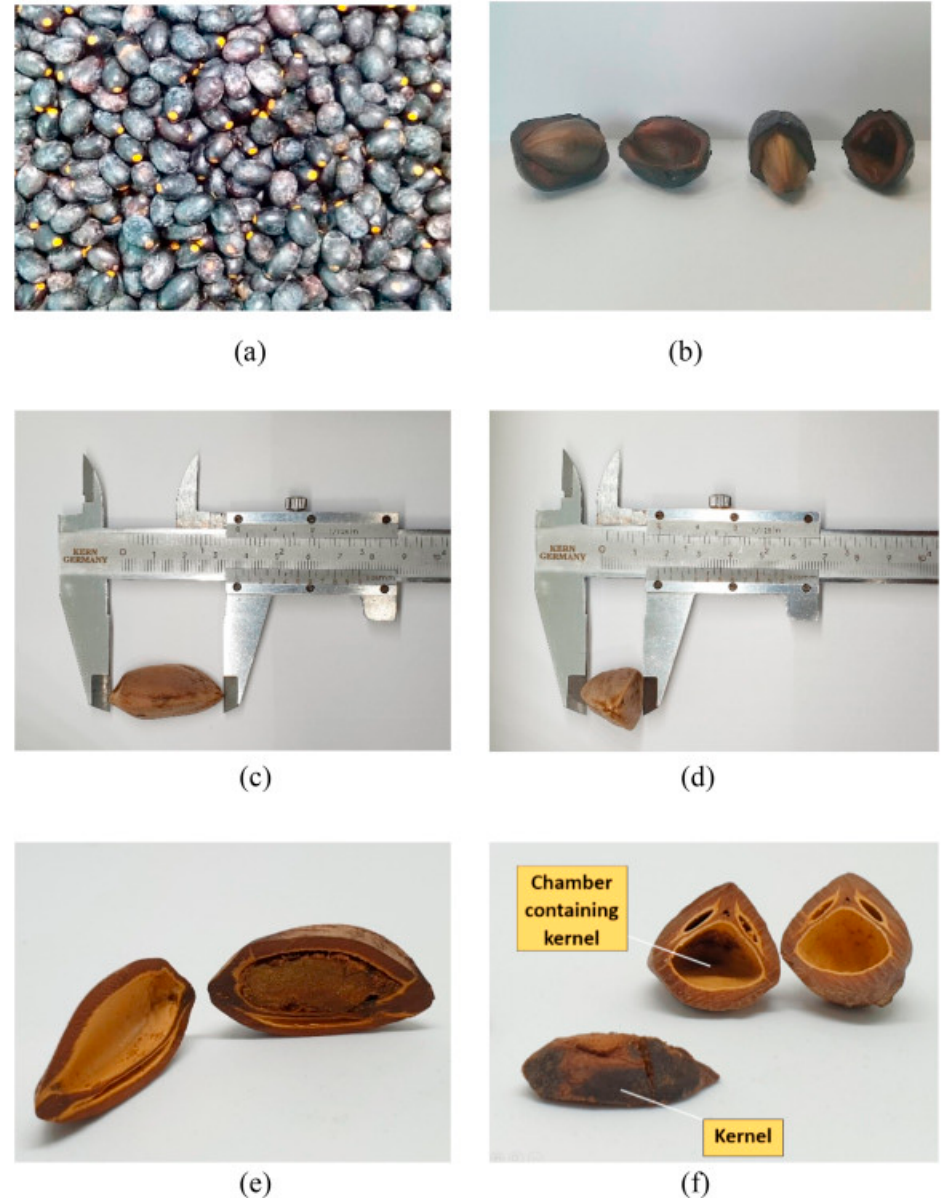
Figure 2. ( a ) Mature dabai fruits; ( b ) Dabai flesh (mesocarp) and hard seed (endocarp); ( c ) Length of the seed; ( d ) Width of the seed; ( e ) Longitudinal section of the seed; ( f ) Transverse section of the seed and the kernel. Adapted from [16].